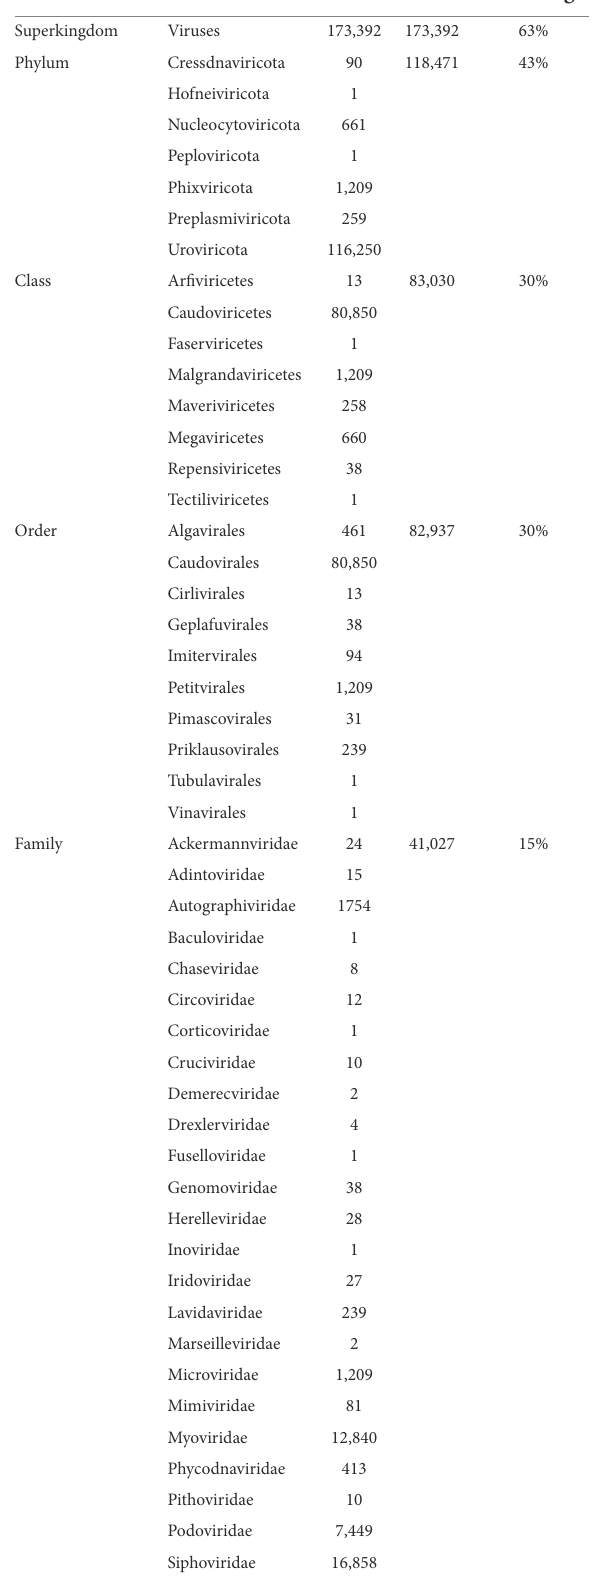
TABLE 3 Breakdown of the different taxonomic assignments of viral contigs. Classification